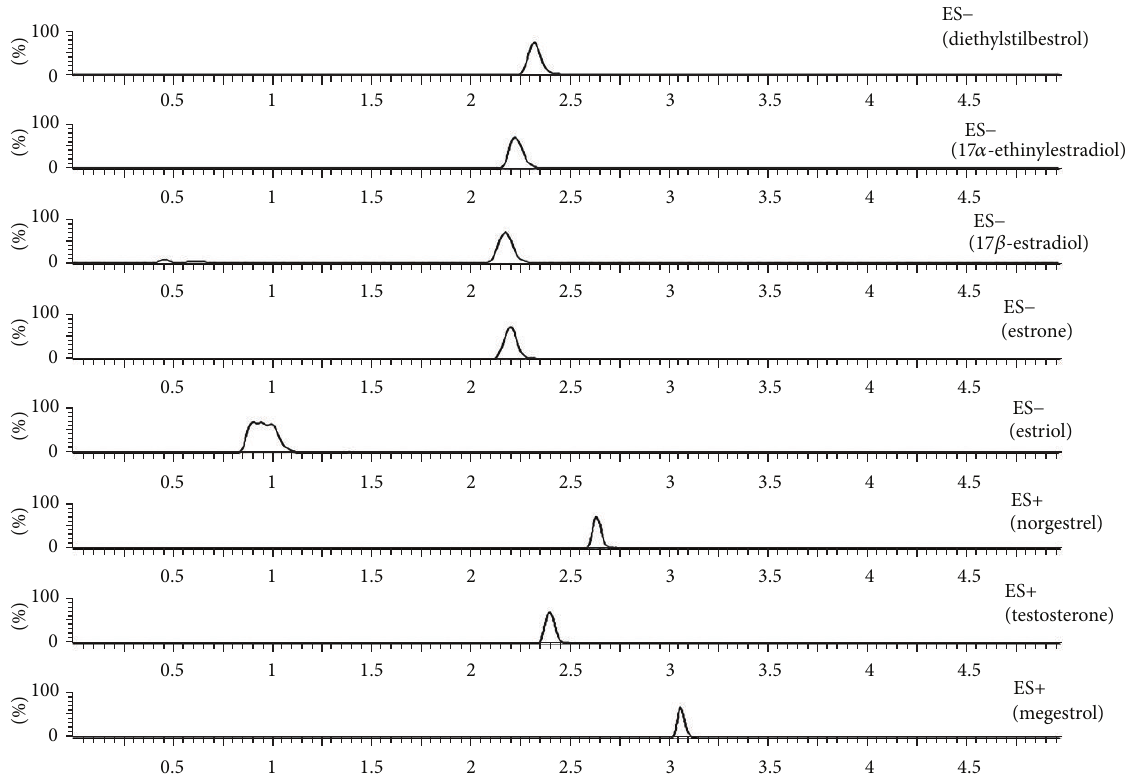
Figure 3: MRM chromatograms of a spiked sample (250 𝜇 g ⋅ L −1 ) with all analytes after SPE